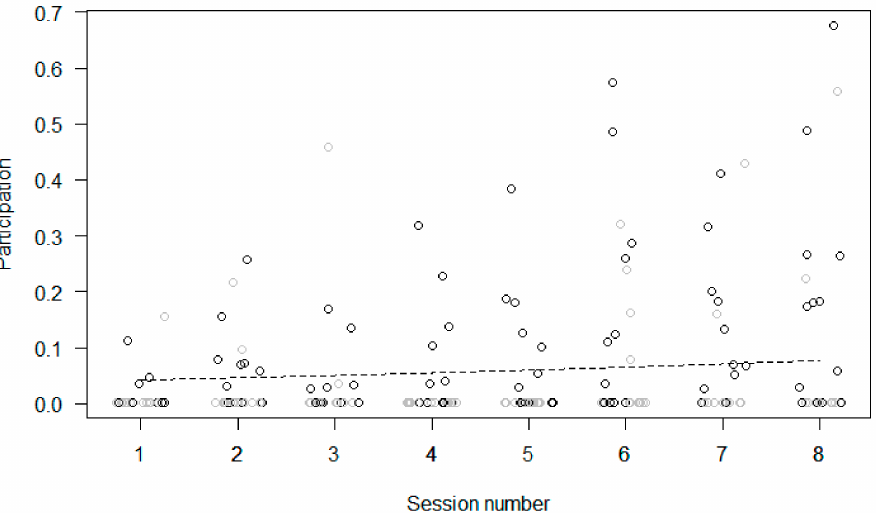
Figure 4. Participation in the enrichment task (i.e., proportion of scans that an individual interacted with the enrichment device in an enrichment session) as a function of time (i.e., enrichment session number) during the treatment phase. Circles represent individual responses in each enrichment session, in the morning (in black) and in the afternoon (in grey). The dashed black line represents the fitted model, which is like Model 1 but unconditional on all the other predictors that were standardized. Data were jittered horizontally to avoid